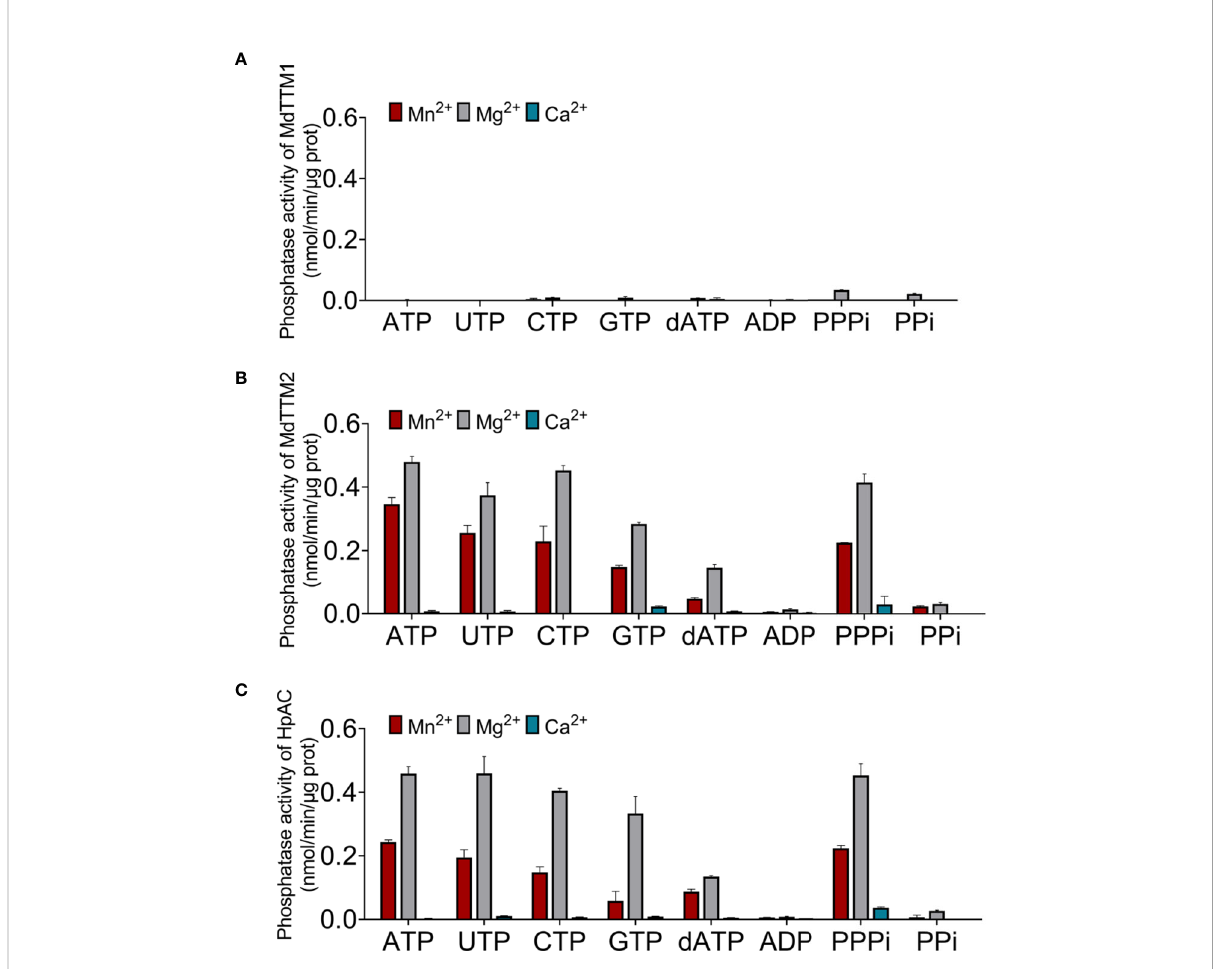
FIGURE 6 Phosphate hydrolysis activity of MdTTM1 (A) , MdTTM2 (B) , and HpAC1 (C) concomitant within Mn 2+ , Mg 2+ , and Ca 2+ . The Pi generated from a reaction mixture, harboring 50 m g of puri fi ed protein, 2.5 mM divalent cation, and with ATP as the substrate, was determined with Malachite Green Phosphate Assay Kits (POMG-25H). At least three independent replications were performed. Error bars represent standard